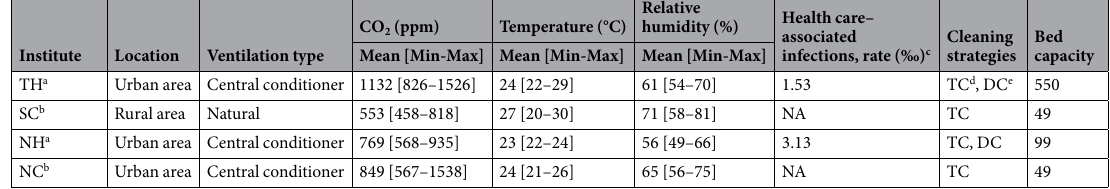
Table 1. Summary of the parameters measured within the four healthcare-associated institutes. a Acute-care hospital; b Long-term care facility; c Per 1000 patient-days; d Terminal cleaning; e Daily cleaning. Notes: The terminal disinfection and daily cleaning procedure followed the description of Chen et al . 2 .